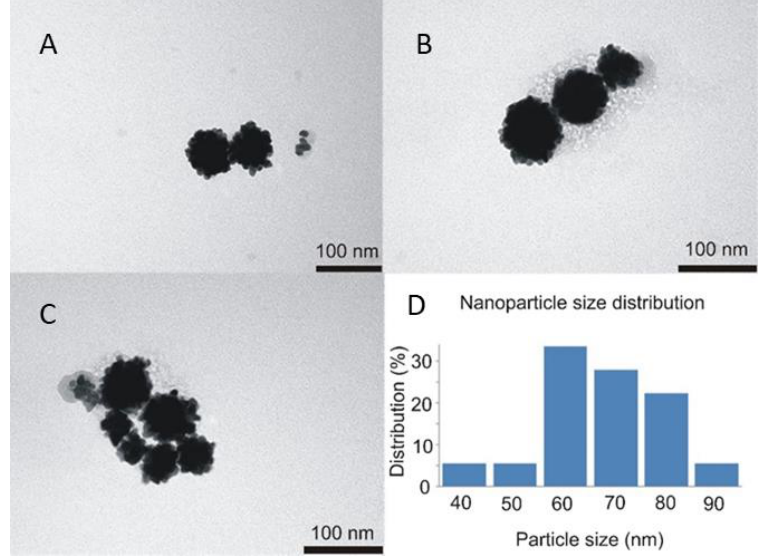
Figure 3. Representative TEM images of clg-AuNPs nanoparticles ( A – C ) and their size distribution ( D ).